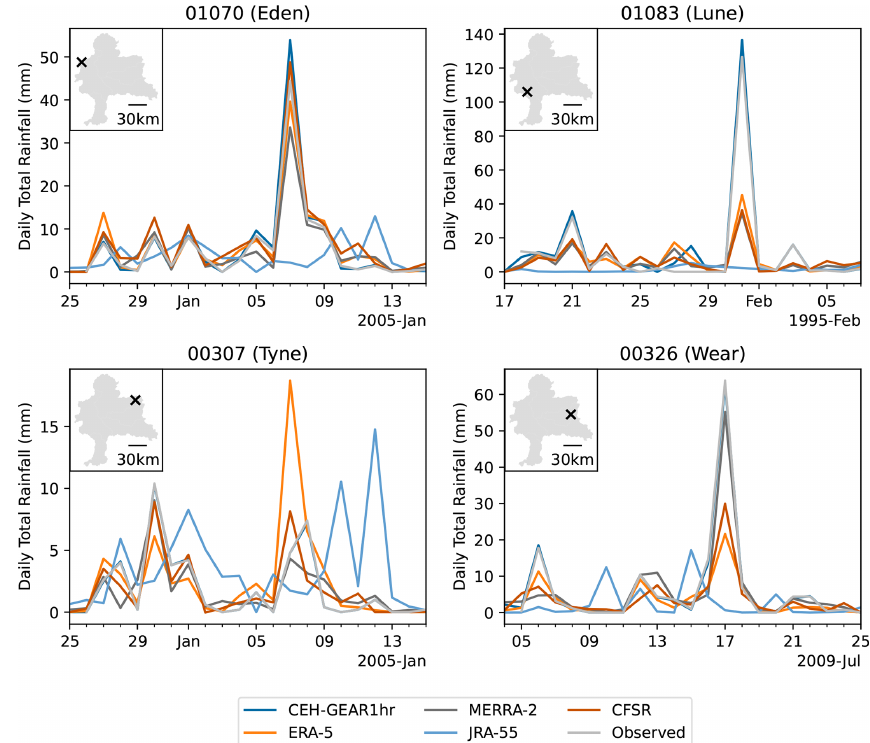
Figure 2. Comparison of daily rainfall totals from each dataset with observed values at selected gauges. The observations were obtained from MIDAS Open (Met Office, 2019). The MIDAS station ID of each gauge is shown in the title of each panel. The series were converted from hourly to daily to improve clarity. CEH-GEAR1hr becomes obscured in places due to it precisely following the observed